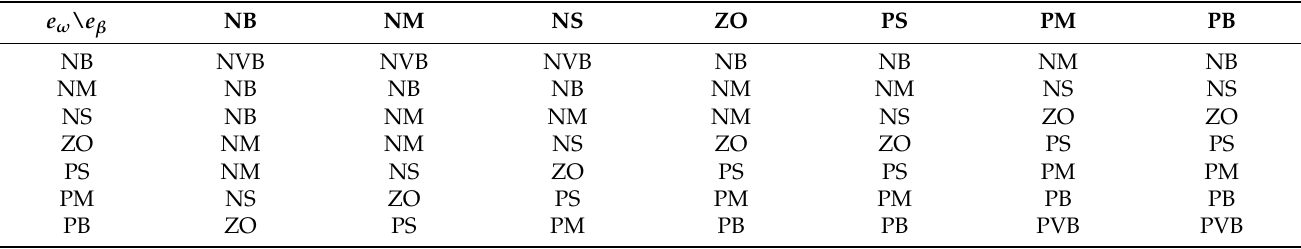
Figure 10. Membership function of the additional yaw moment. Fuzzy reasoning is the core link in fuzzy control, which is to form a one-to-one rule put variable based on expert experience. The reasoning relationships used in this study are shown in Table 2, with a total of 49 fuzzy rules. Table 2. Fuzzy control fuzzy rule table.